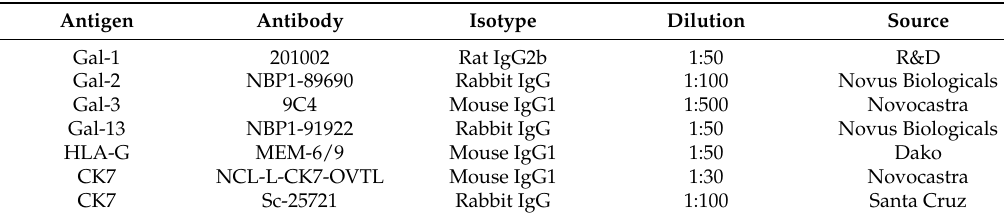
Table 2. Antibodies used in the